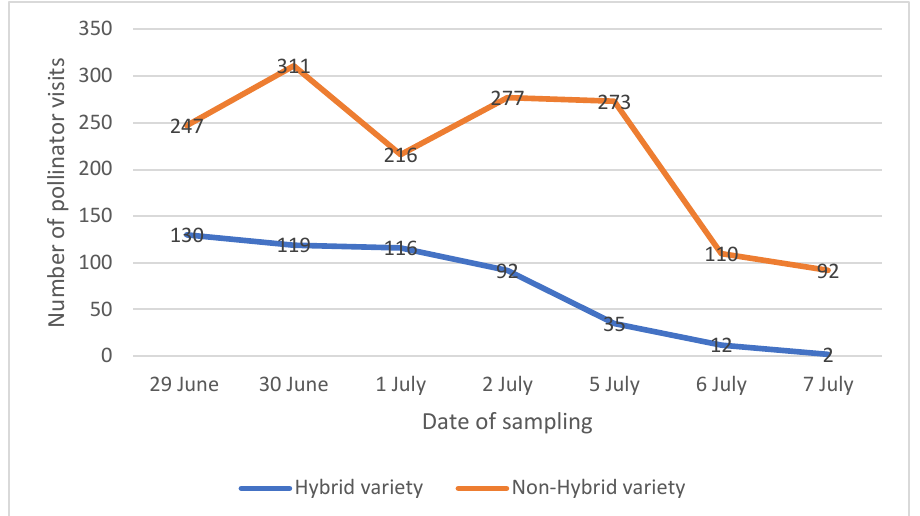
Figure 1. Results of image analysis of the visits of some pollinator insects on the flower heads of the two varieties. The values reported refer to the number of insects photographed during 1.5 h on two flower heads, intended as the sum of bumblebees and honeybees.